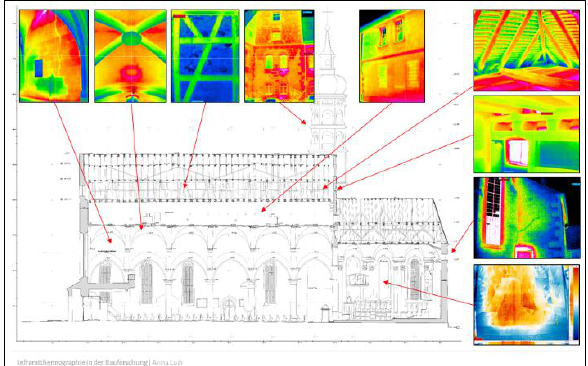
Figure 9: Potential applications of IRT for Building Archaeological